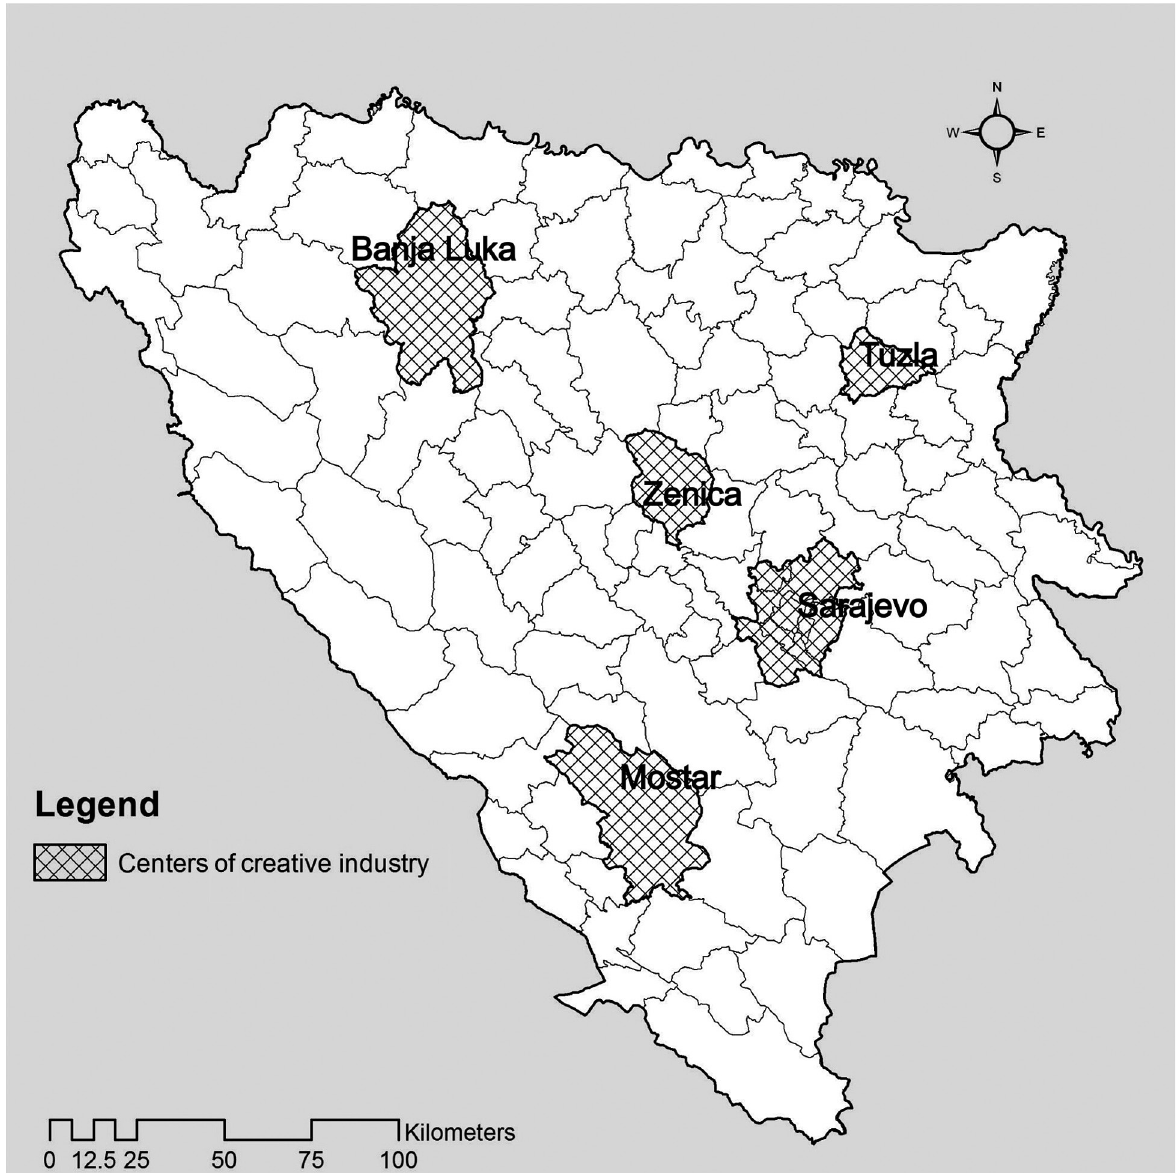
Fig. 1. Centres of the creative industries in Bosnia and Herzegovina, 2011. author: R.